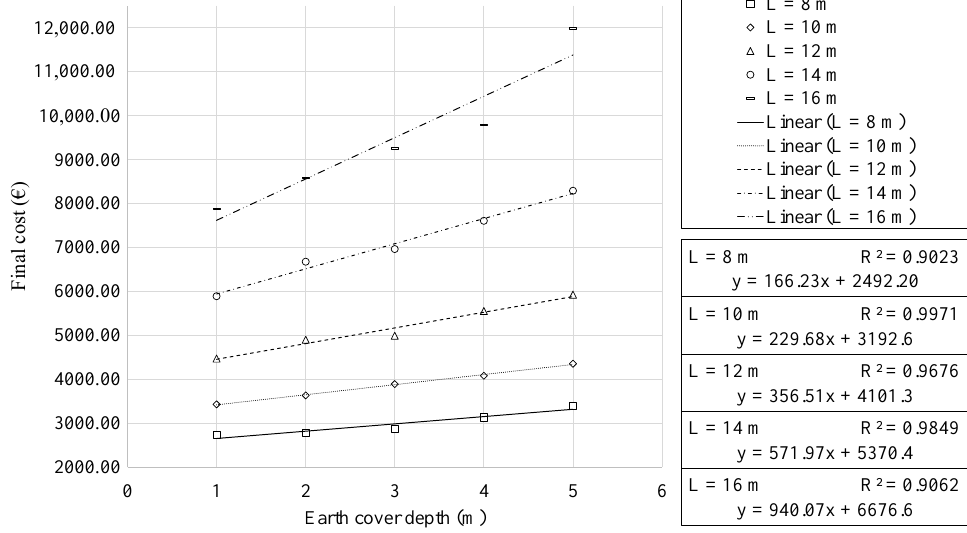
Figure 4. Cost of the RMHF as function of the earth cover, for each horizontal span.